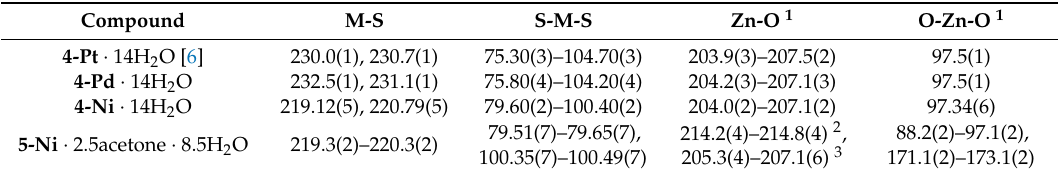
Table 2. Selected interatomic distances (pm) and angles (deg.) in heterobimetallic coordination polymers of the type Zn 2 [M(L) 2 ] (M = Ni, Pd, Pt).